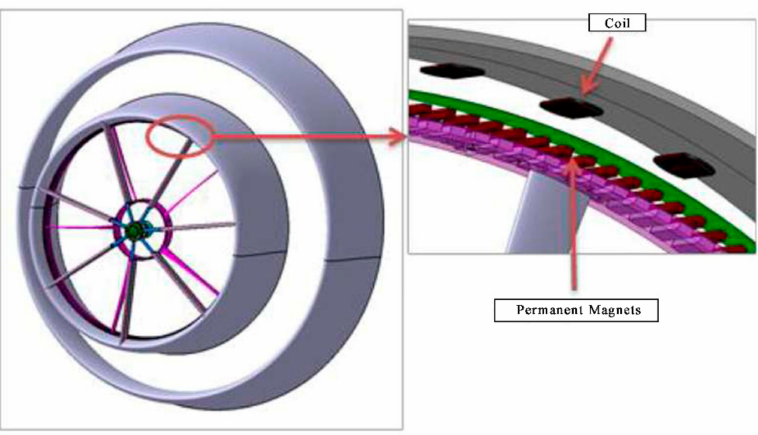
Figure 1. 3D sketch of the APMM integrated within the DHAWT